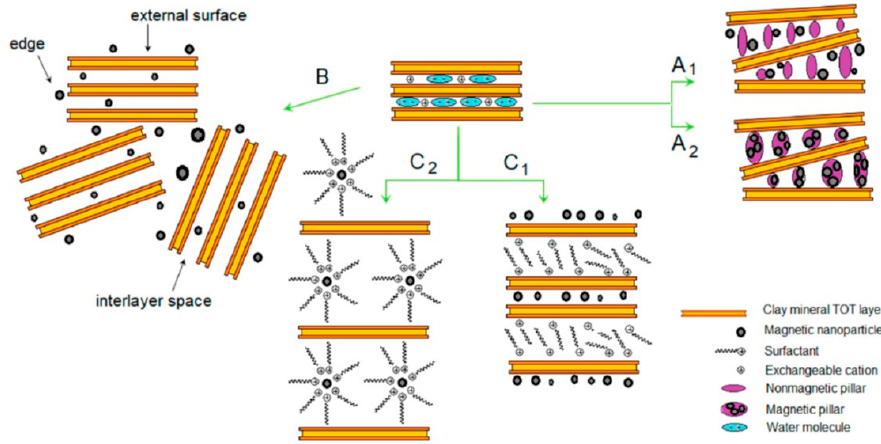
Figure 4. Schematic illustration of typical synthesis routes to obtain magnetic nanoparticles/clay minerals 2:1 type nanocomposites: (A1) pillaring with nonmagnetic pillar; (A2) pillaring with magnetic pillar; (B) coprecipitation route; (C1) intercalation of magnetic nanoparticles into a surfactant intercalated clay; (C2) intercalation of a surfactant-modified magnetic nanoparticles into a clay. Reprinted with permission from [10]. Copyright 2020 MDPI.